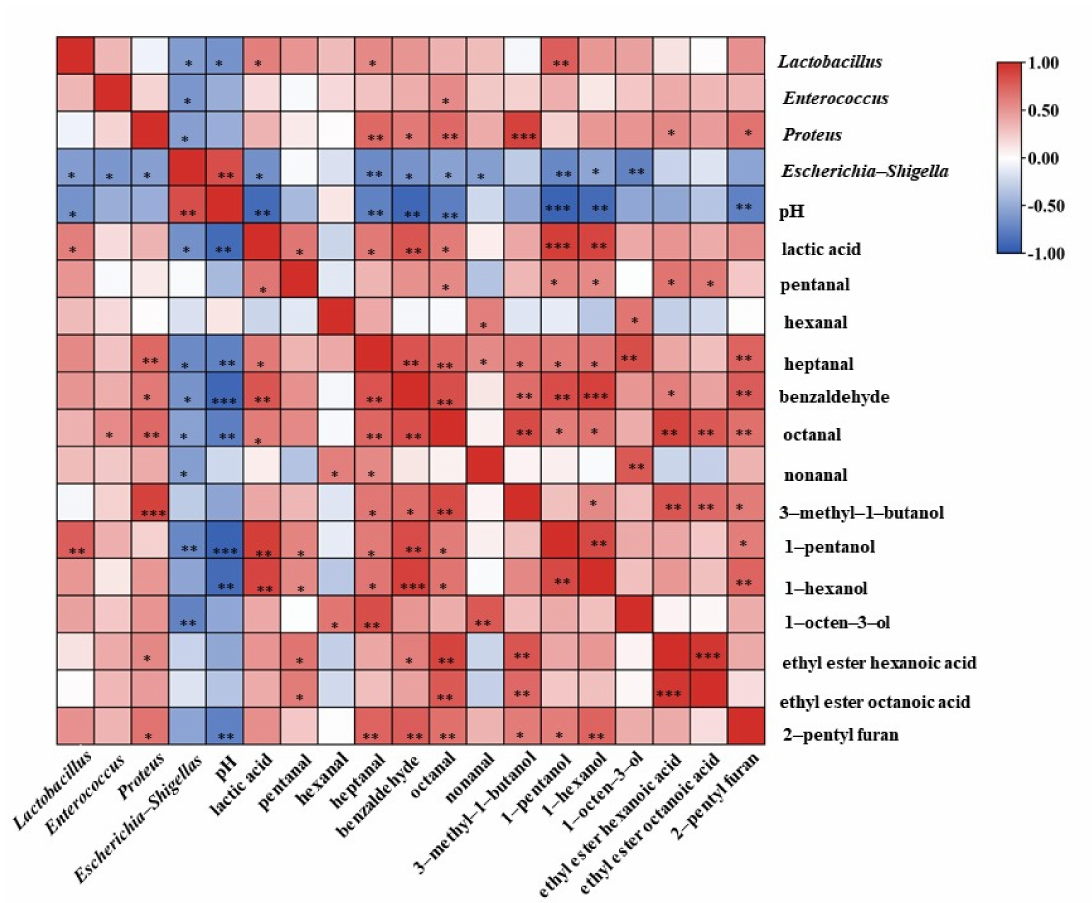
Figure 4. Correlations between the bacterial communities with volatile compounds (OAV > 1), pH and lactic acid in Suanzhayu samples. Red indicates positive correlations, while blue indicates negative correlations. Significant at: * ( p < 0.05); ** ( p < 0.01); *** ( p <